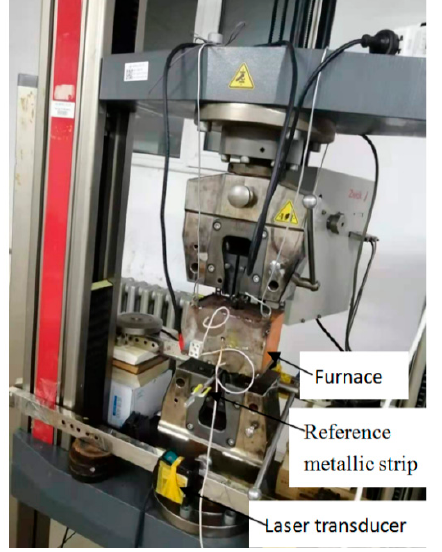
Figure 2. Test setup.